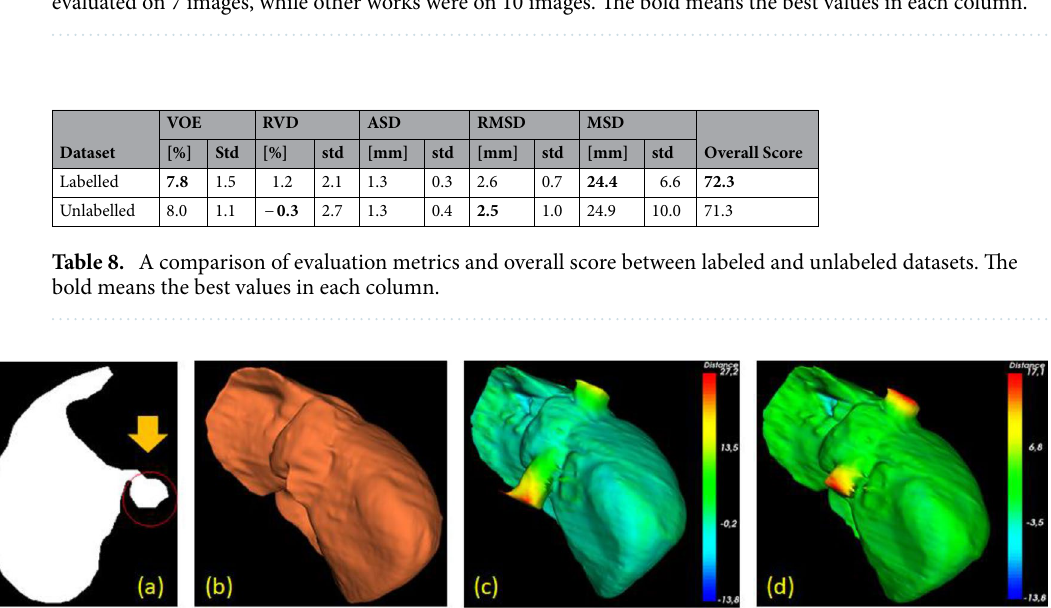
Table 7. Comparison evaluation metrics and score obtained by using different algorithms. *Our scores were evaluated on 7 images, while other works were on 10 images. The bold means the best values in each column.